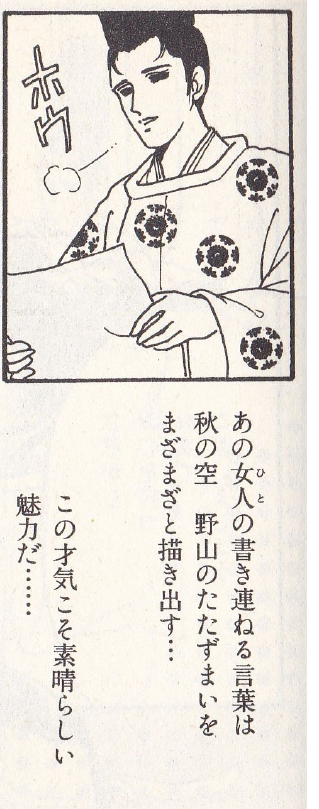
Figure 13. The Prince reads a letter from the woman (Kosakabe and Tanaka, Manga Izumi Shikibu nikki , 1990), 183. Courtesy of